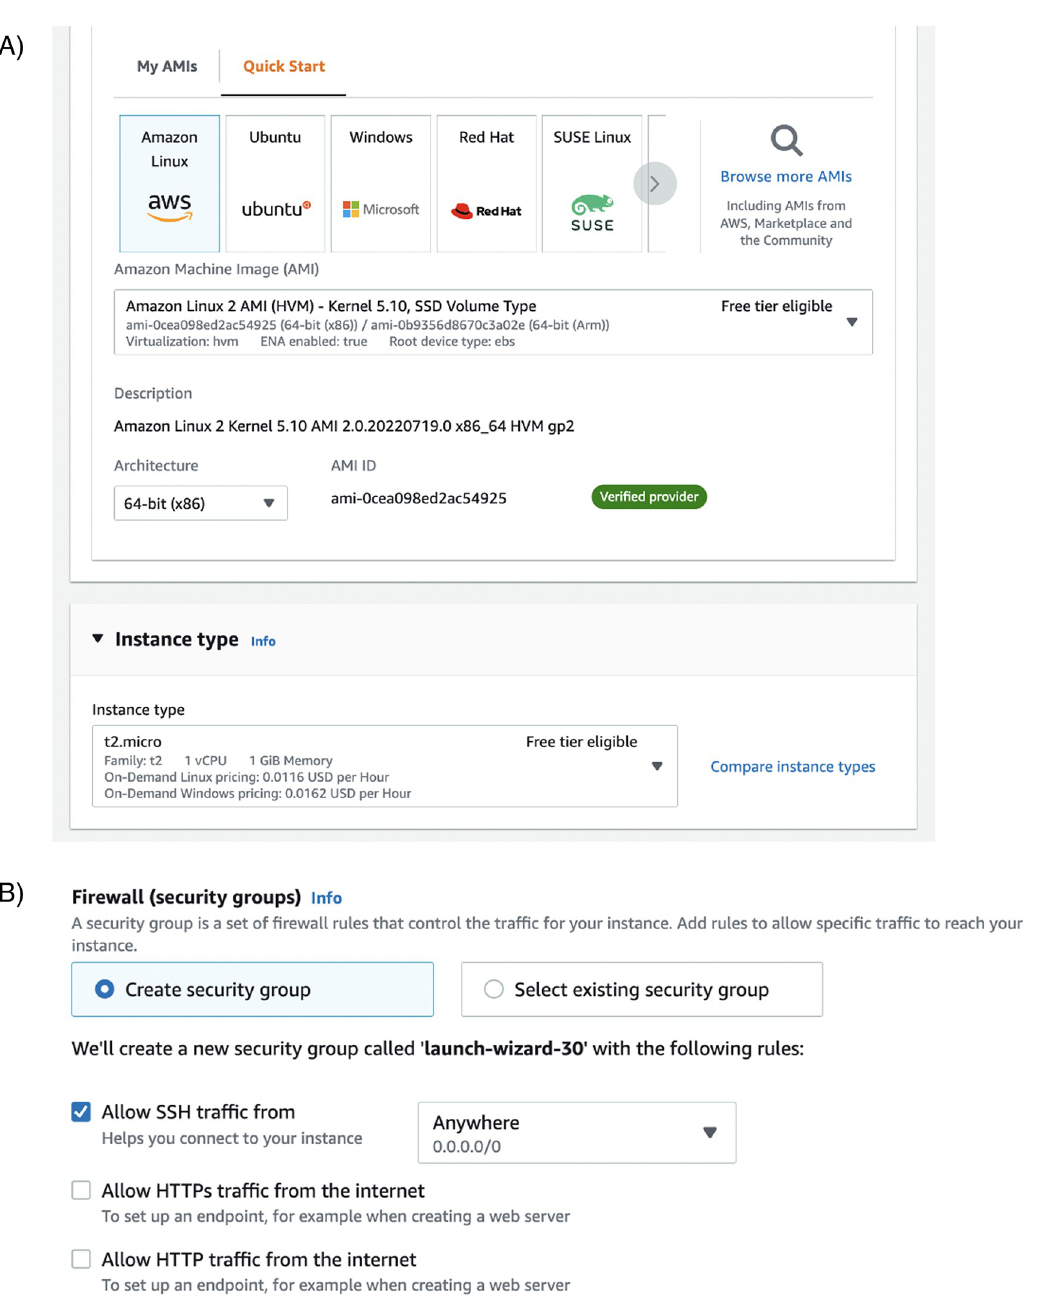
Fig 4. (Right) To launch an EC2 instance, you need to pick an operating system (standard Amazon Linux will provide flexibility for new users) and technical parameters, such as CPU power and memory (RAM). Standard unit of computing power is virtual CPU, vCPU. There is no linear relationship between physical processors and vCPU, but one virtual CPU unit corresponds to a single thread. Correctly selecting the number of vCPUs for your code might require experimenting. Some instances come with graphical processing units (GPU), other instances provide access to fast solid-state drive storage. (Right) Second part of launching an instance is selecting access rules. It includes setting up private-public key pair for passwordless login, and allowing firewall rules for SSH traffic (terminal) and potentially also traffic on ports associated with Jupyter notebook server (such as 8000 port).